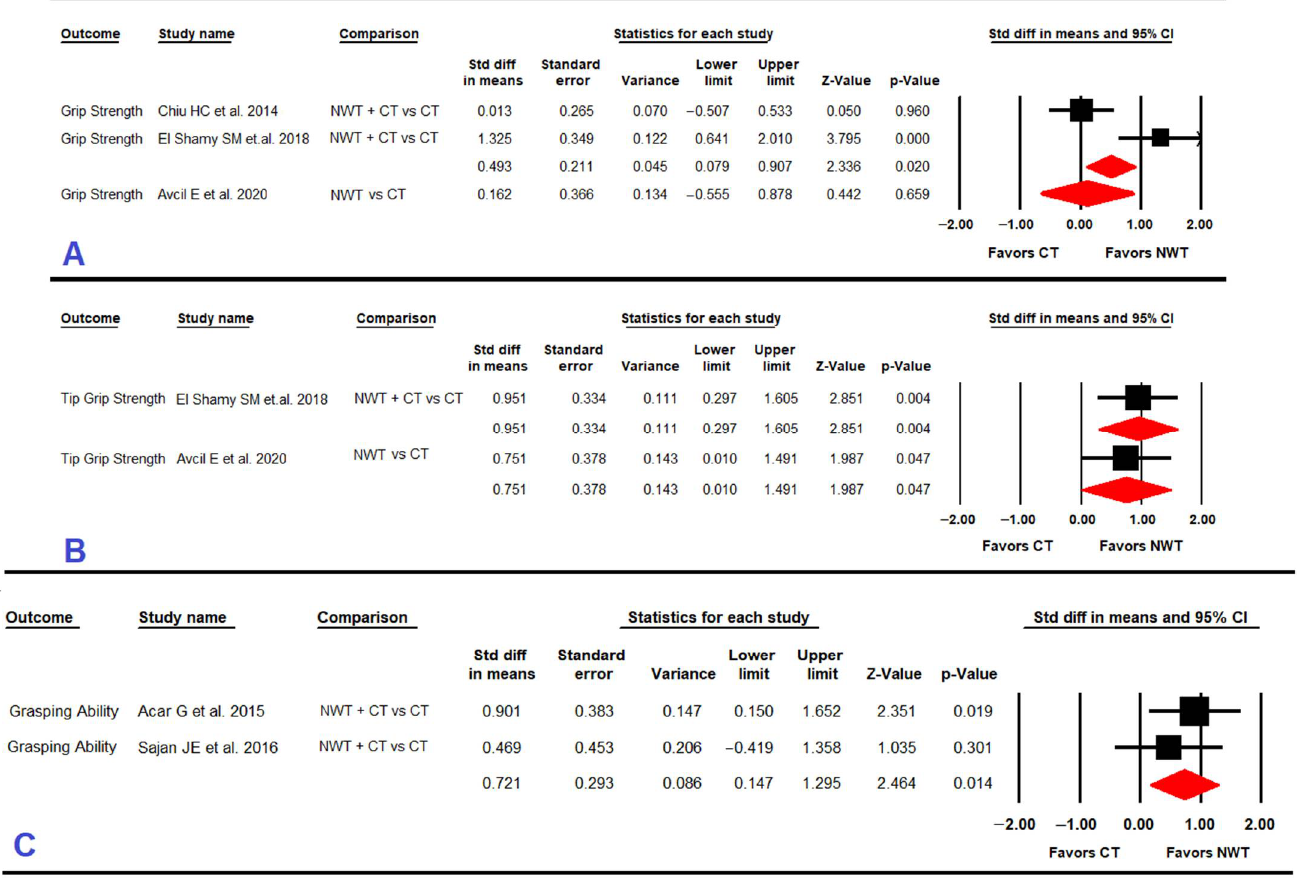
Figure 2. Forest plot effect of Nintendo ® Wii therapy on grip strength ( A ), on tip grip strength ( B ), and on grasping ability ( C ).